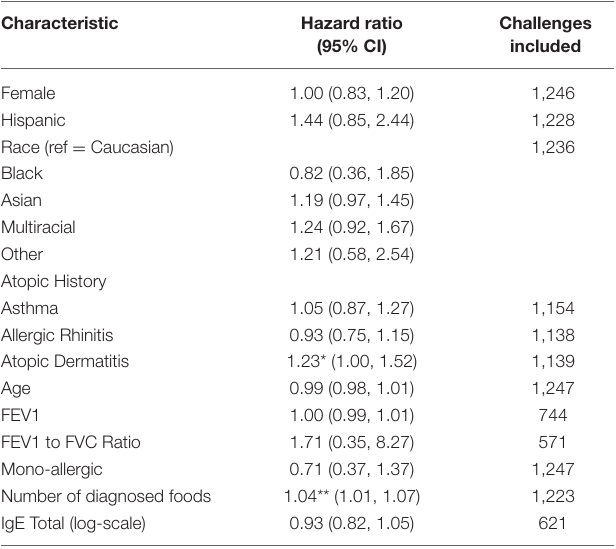
TABLE 4 | Univariable associations of positive